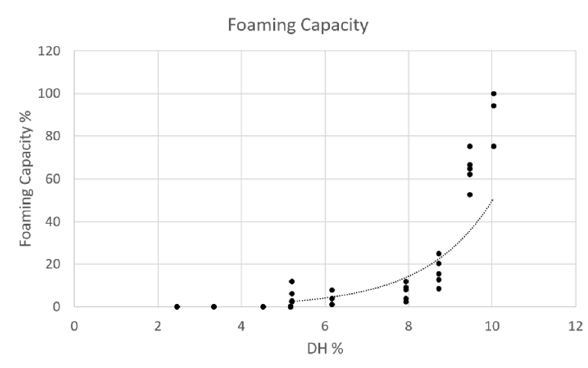
Figure 5. Foaming capacity of 1% of protein samples (average pH 7.9 ± 0.3 and ionic strength of 2.8 ± 0.2 mS / cm) reported in function of DH% with the trendline. The analysis was done in triplicate.